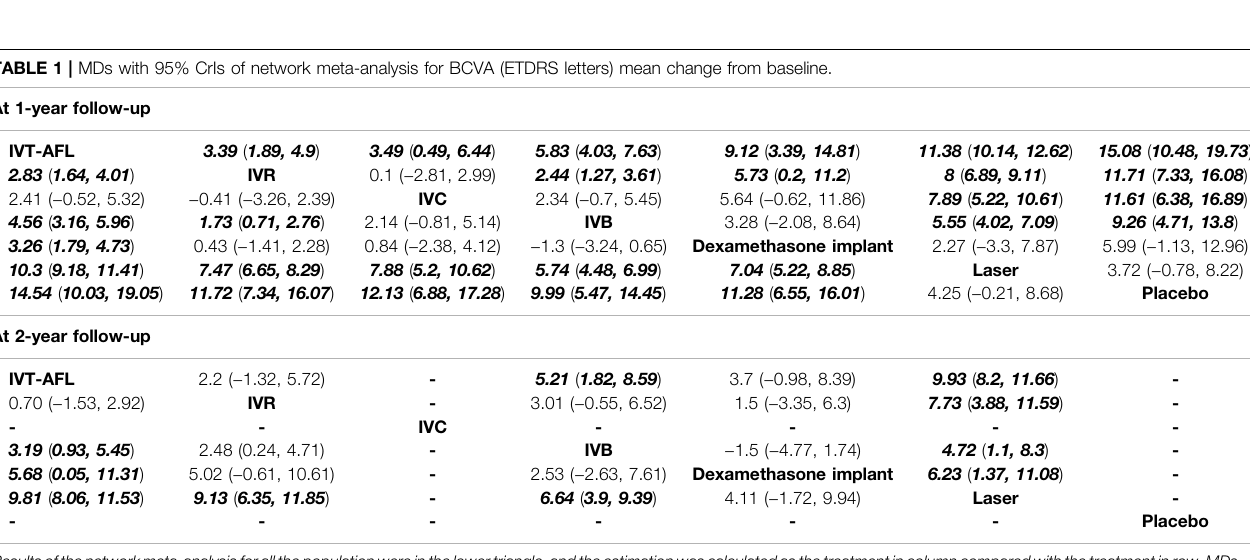
FIGURE 3 | Network geometry for BCVA (ETDRS letters) mean change from baseline. All populations at 1-year follow-up [ (A) 18 trials] and 2-year follow-up [ (C) 5 trials].PopulationwithworsebaselineVAat1-yearfollow-up[ (B) 12trials]and2-yearfollow-up[ (D) 5trials].BCVA,best-correctedvisualacuity;ETDRS,EarlyTreatment Diabetic Retinopathy Study; IVB, intravitreal bevacizumab; IVC, intravitreal conbercept; IVR, intravitreal ranibizumab; IVT-AFL, intravitreal a fl ibercept. Notes: Direct comparisons are represented by the black lines connecting the different interventions. Line width is proportional to the number of trials including every pair of interventions, whereas circle size is proportional to the total number of trials for each intervention in the network.